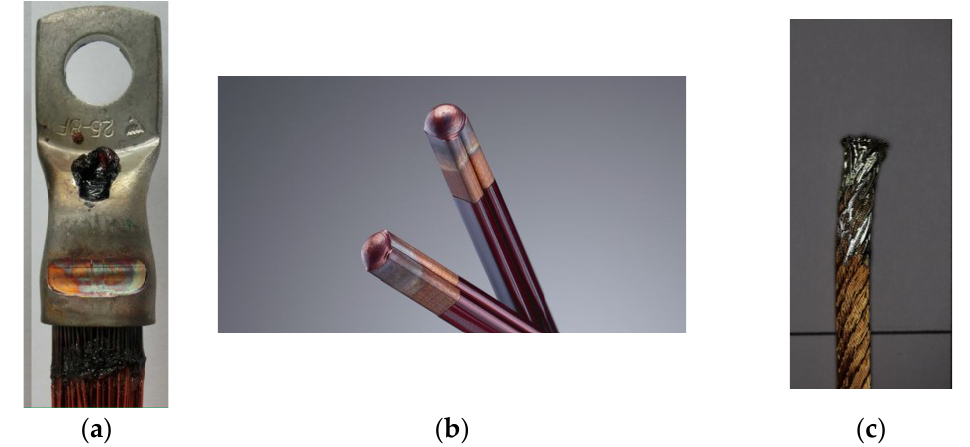
Figure 1. Images showing a few examples of terminations made from various technologies ( a ) Hot crimped termination ( b ) A laser-welded joint ( c ) A dip-soldered termination